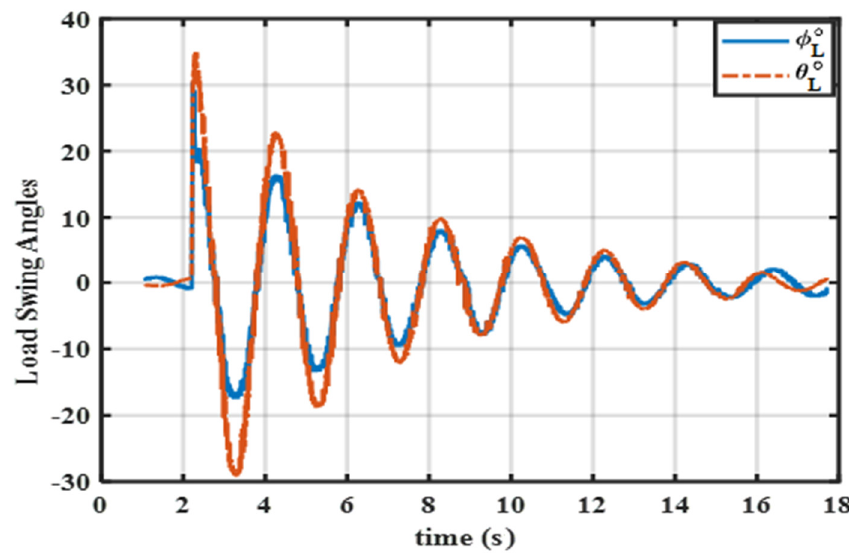
Figure 16. Time history of the load swing angle during hover without the ASC.